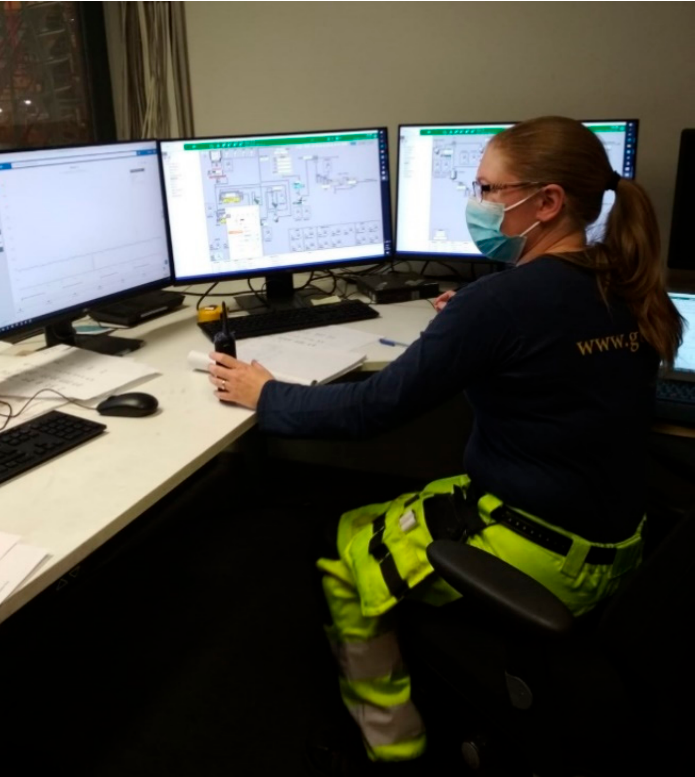
Figure 12. Control room of the GTK Mintec pilot plant. Operators can control the processing plant through the automation and control system.